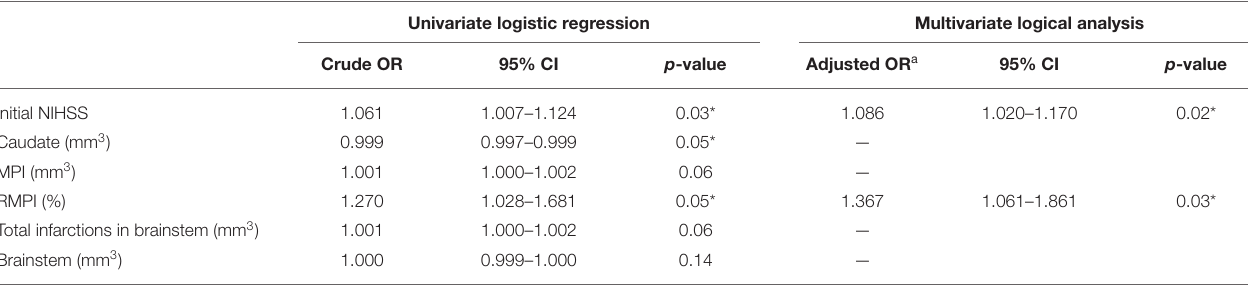
TABLE 3 | Univariate and multivariate logical analyses for clinical outcome